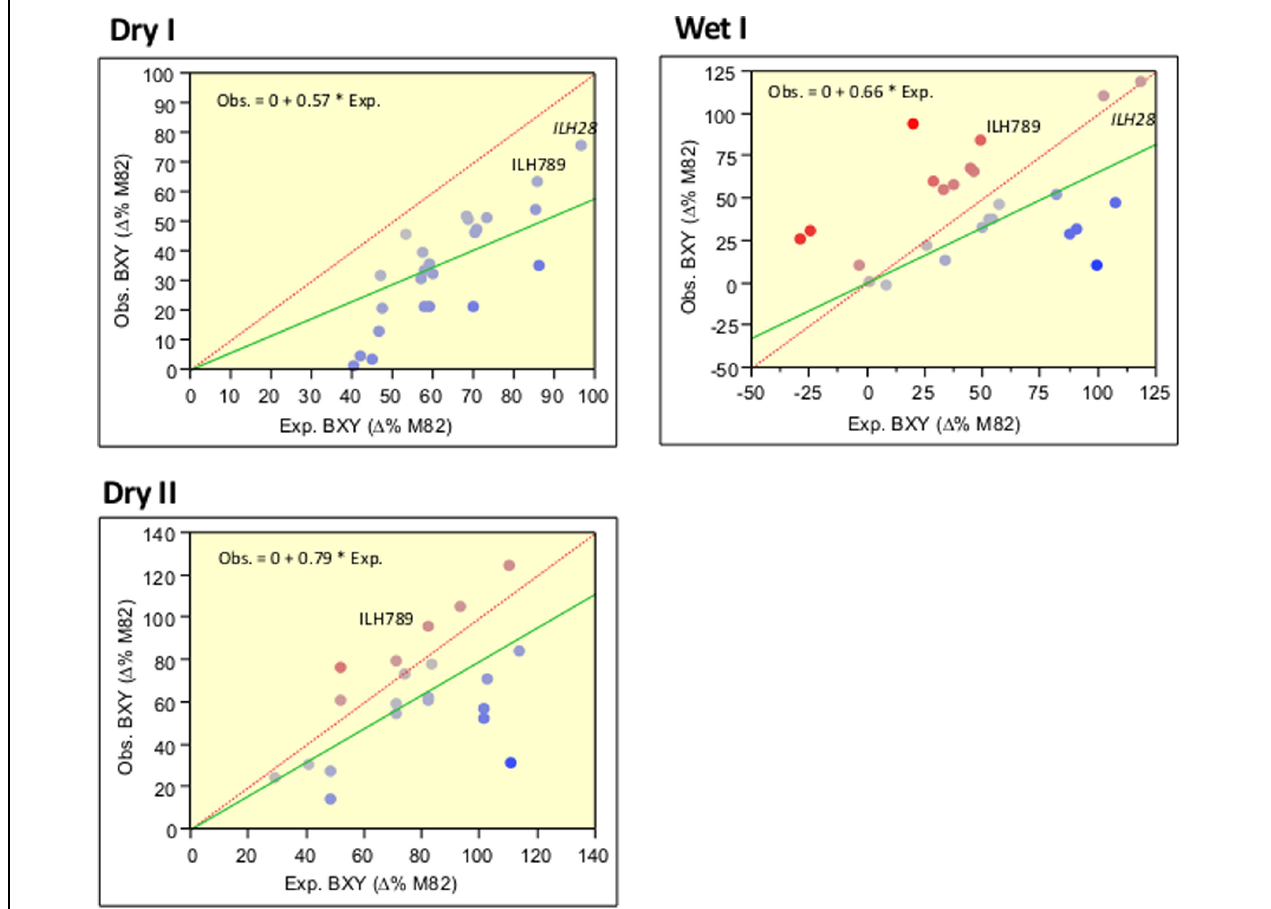
FIGURE 2 | Correlations between expected and observed BXY across 45 double and triple hybrids in the wet and dry fields over 2 years. Expected ( X axis) and observed ( Y axis) BXY values are presented for double and triple ILHs that resulted from crosses between single or double ILs. BXY values are presented as percent difference from M82. Expected values were calculated as the sum of the single ILH effects, assuming complete additivity. The dashed red line represents the expected regression line where X = Y and intercept is 0,0. The green line represents the observed regression line, with the intercept constrained to 0,0, which is the value of M82. Equations for the observed by expected regression lines are presented at the left upper corner of each box. Slopes of all regression lines are significantly lower than 1. The Red-to-Blue scale reflects the deviation from the X = Y